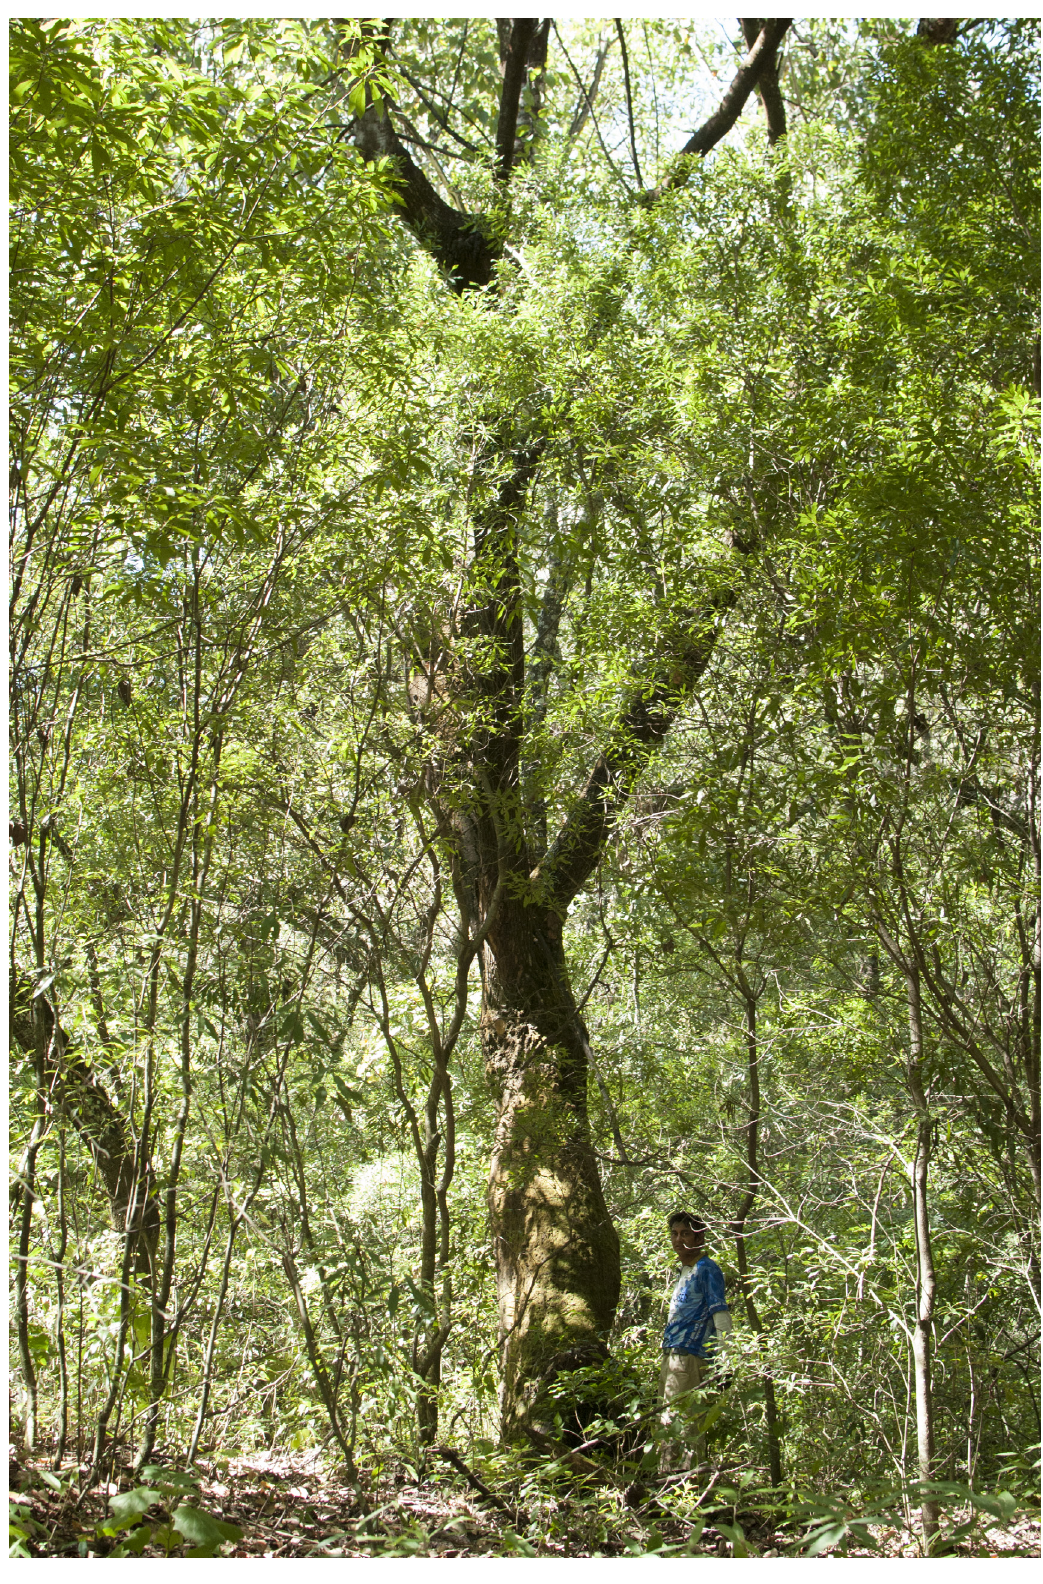
Fig. 2. Populus primaveralepensis A.Vázquez, Muñiz-Castro & Zuno sp. nov. Tree showing its habit and bark. J. Padilla Lepe, standing next to the tree; photograph: O.